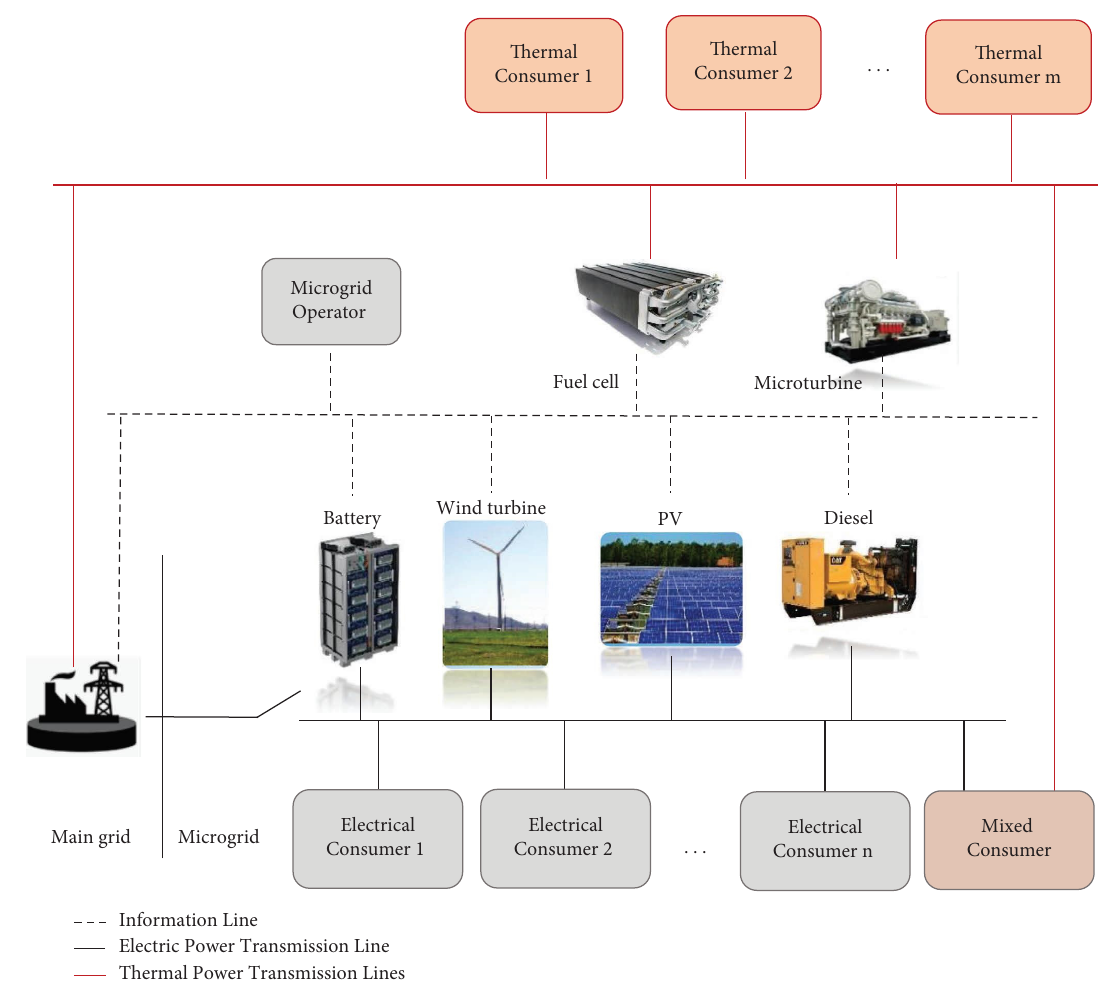
Figure 1: Microgrid